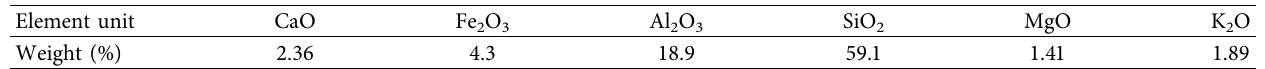
Table 3: Main chemical composition of gangue.